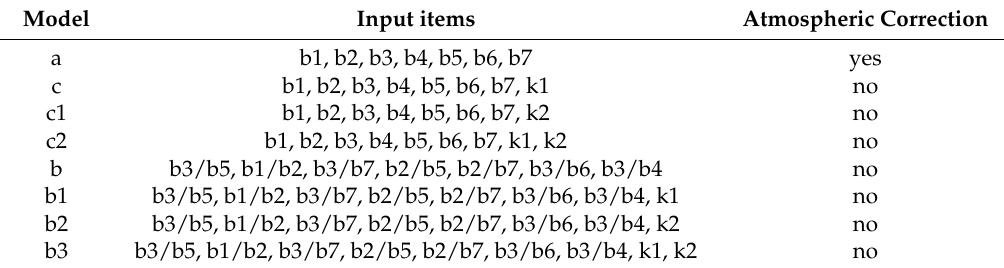
Table 3. Input parameters of eight RBF neural network